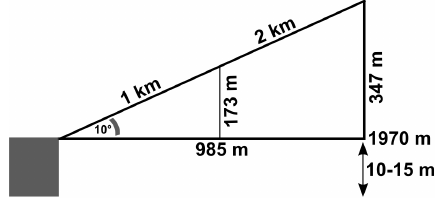
Figure 17. Illustration of the measurement geometry of Fig. 16.